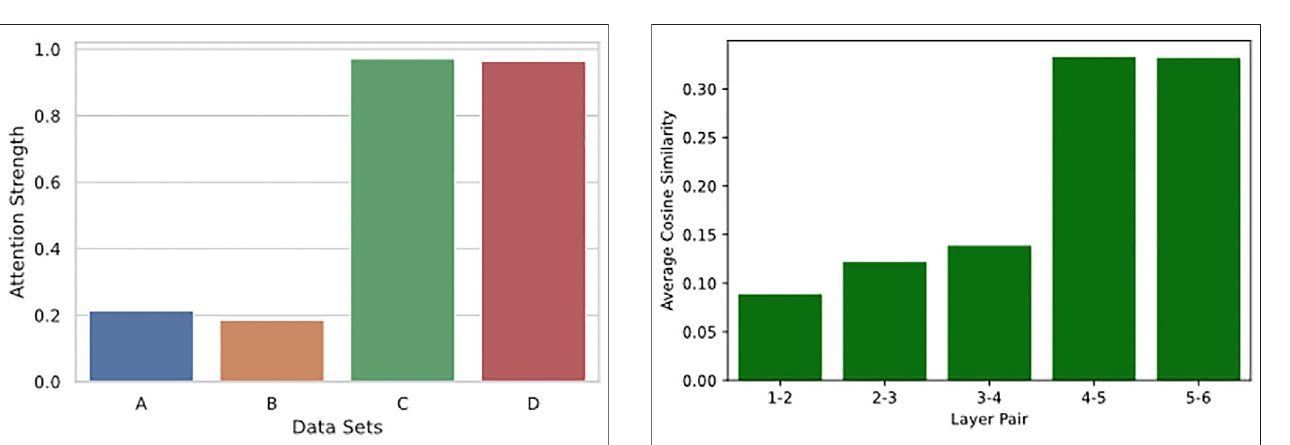
Figure 6 . We used the Mann-Whitney U test and found that the differences between all sets of attention strength are signi fi cant 7 . As we previously argued, signi fi cance testing for large data sets has to be accompanied by measuring the effect size to decide if the difference can be neglected. We used Cohen ’ s d and found that the effect size of signi fi cance is large between sets from the fi rst and the last layer (A-C: 2.447, A-D: 2.381, B-C: 2.661, B-D: 2.586) and very small between sets within the same layer (A-B: 0.073, C-D: